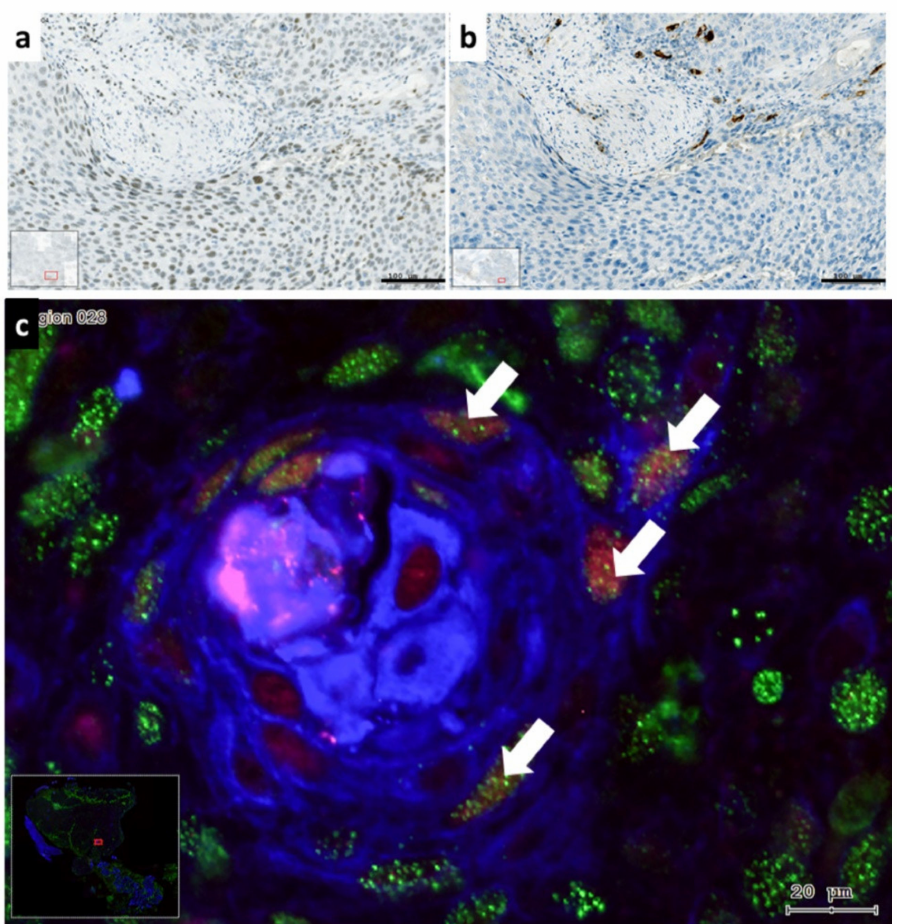
Figure 6. Comparison of enzyme immunohistochemical labeling of Slug ( a ) and TGF- β 1 ( b ) with immunofluorescence labeling of KLF4 (red), pan-cytokeratin (blue) and vimentin (green); combined ( c ) in HNSCC with loss of p53 gene product. The Slug + cells were diffusely present in the cancer cell nest ( a ). In this location scattered stroma cells reacted positively with antibody against TGF- β 1 ( b ). Using increased magnification acquisition of the combined immunofluorescence labeling of CK, vimentin and KLF4 ( c ), more cells with combined KLF4, vimentin and CK ( c ), were detected (white arrows). Bars: 100 µ m in brightfield and 20 µ m in fluorescence. The colors in fluorescence were chosen to present the co-localizations